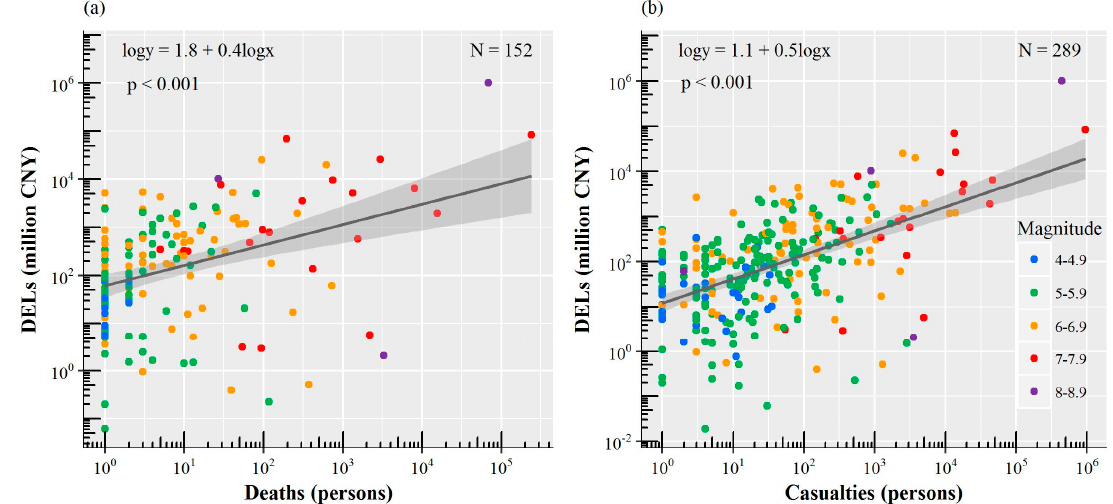
Figure 7. Earthquake-induced DELs versus deaths ( a ) and casualties ( b ) by earthquake magnitude. ( a ) The earthquake disasters plotted in these figures are earthquakes with both at least one death and reported DELs. ( b ) Same as ( a ), but for casualties. Nonparametric smooth curves with 95% confidence interval are shown in gray.